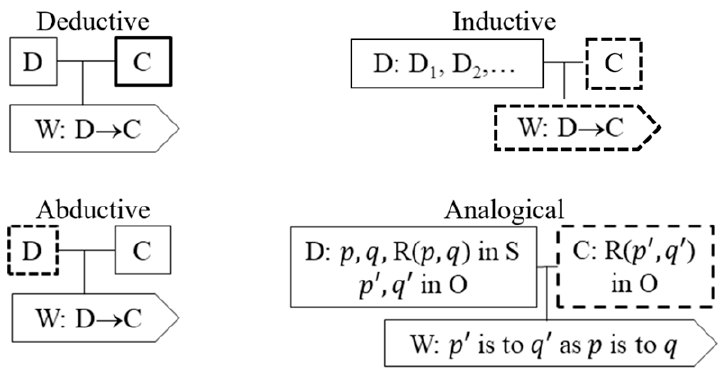
Figure 1. Diagrams for each type of argument.